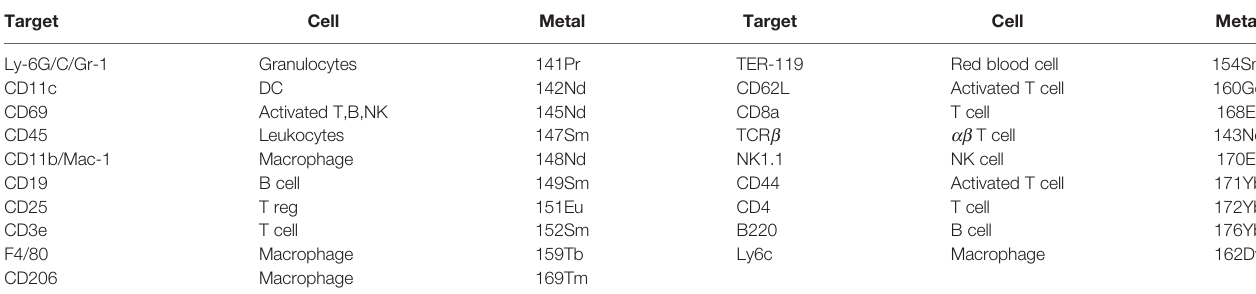
TABLE 1 | List of metal-tagged antibodies of surface